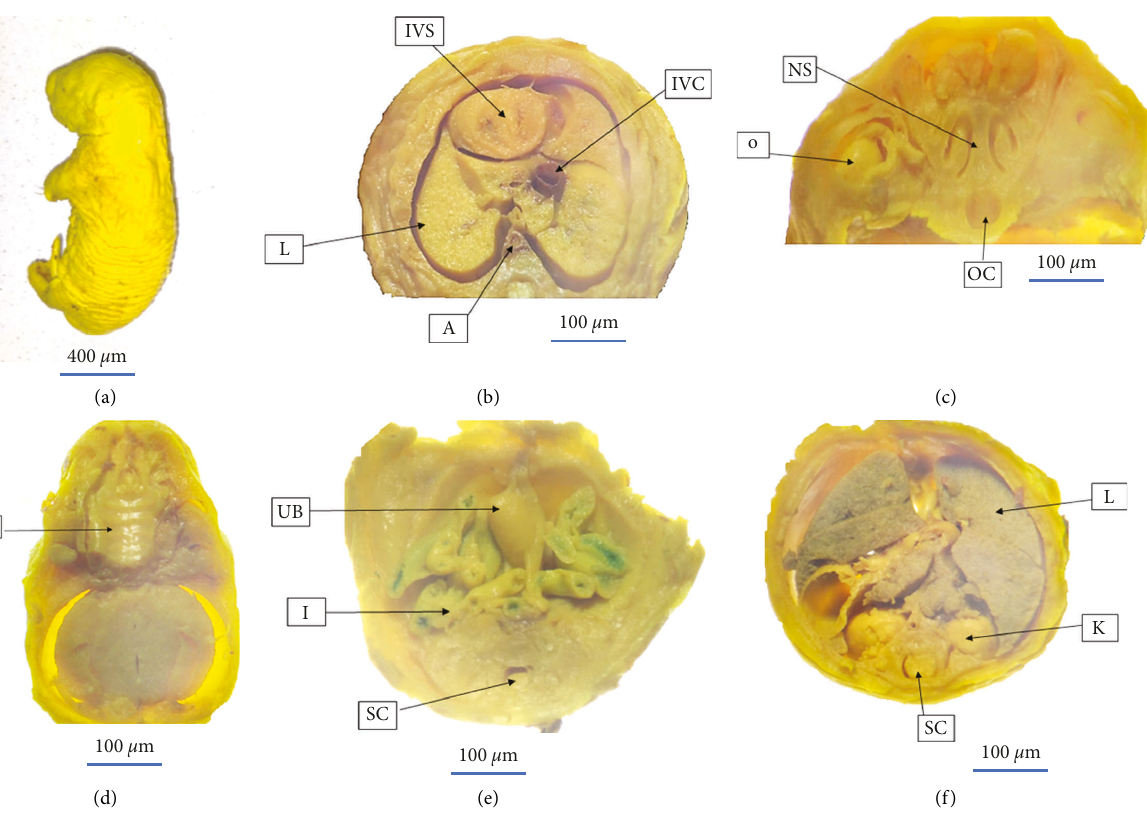
Figure 4: Visceral structures before and after sectioning at different level of the body based on free-hand razor blade sectioning technique. (a) A matured fetus before sectioning. (b) (A: aorta, IVC: inferior vena cava, IVS: interventricular septum, and L: lung). (c) (NS: nasal septum, (O) orbit, and OC: oral cavity). (d) (P: palate). (e) (I: intestine, SC: spinal cord, and UB: urinary bladder). (f) (K: kidney, (L) lung, and SC: spinal cord).